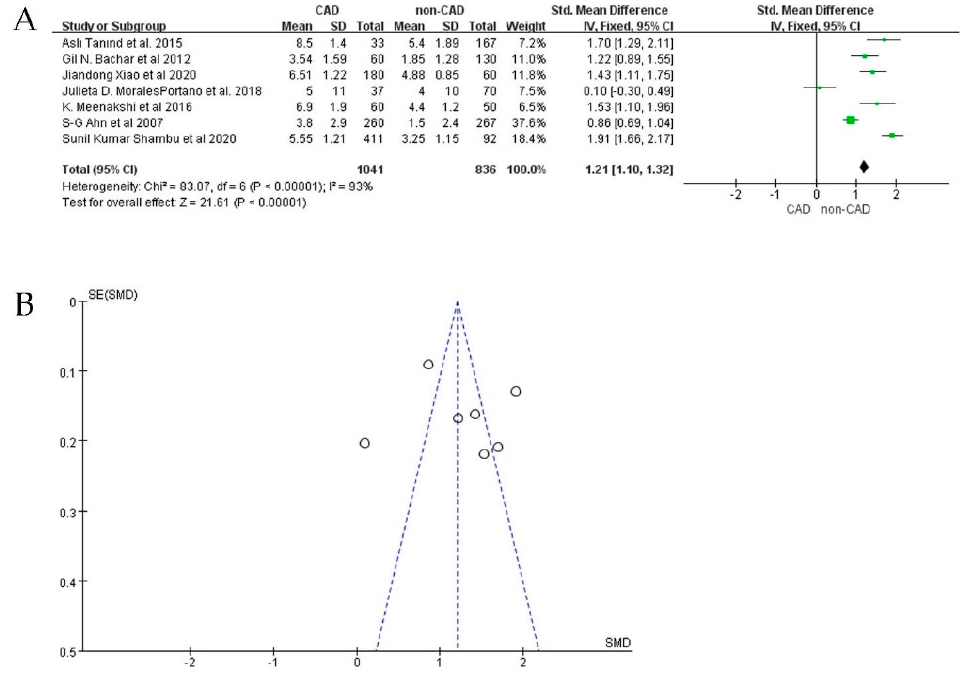
Figure 3. SMD by EAT thickness between CAD patients and non − CAD patients. ( A ) Forest plot; ( B ) funnel plot.